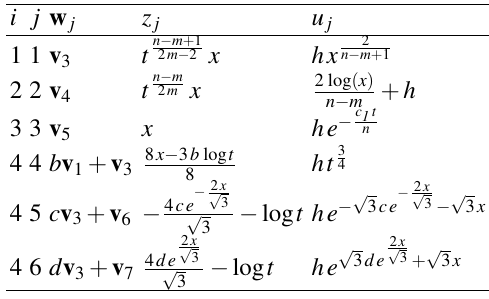
Table 3: Similarity solutions.